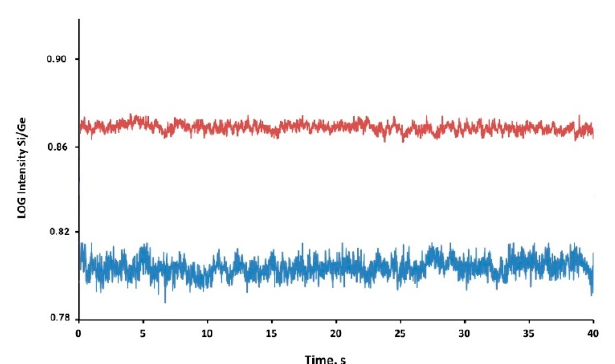
Figure 1. Signal profile of ultrapure water analyzed with the standard configuration in quartz (red line) and after replacement with non-quartz components (blue line). Ratios of logarithms of Si and Ge intensities are shown.